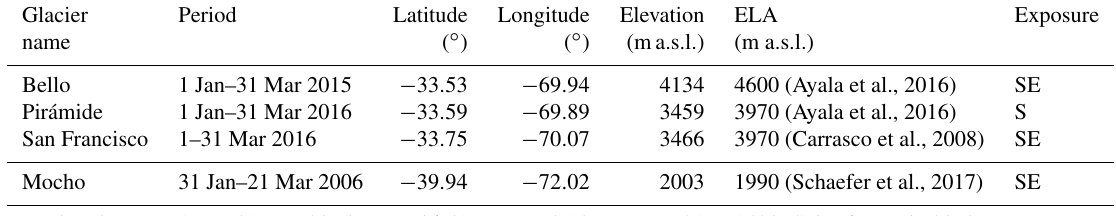
Table 1. Study period and geographical information of the glaciers and automatic weather stations. ELA is equilibrium line altitude. Glacier Period